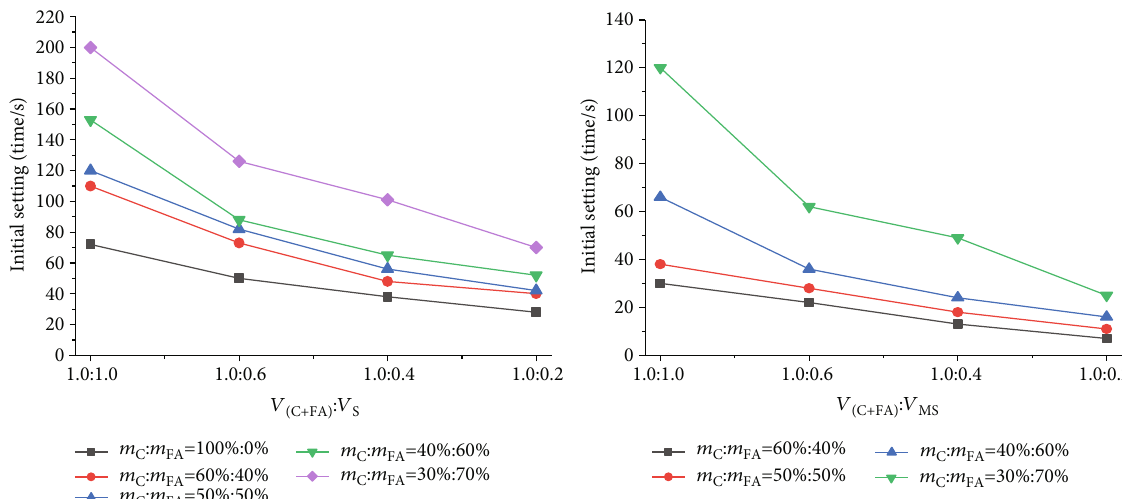
Figure 1: Curves of initial setting time. Note: m ratio of the C-FA slurry to the pure S solution, and V ð